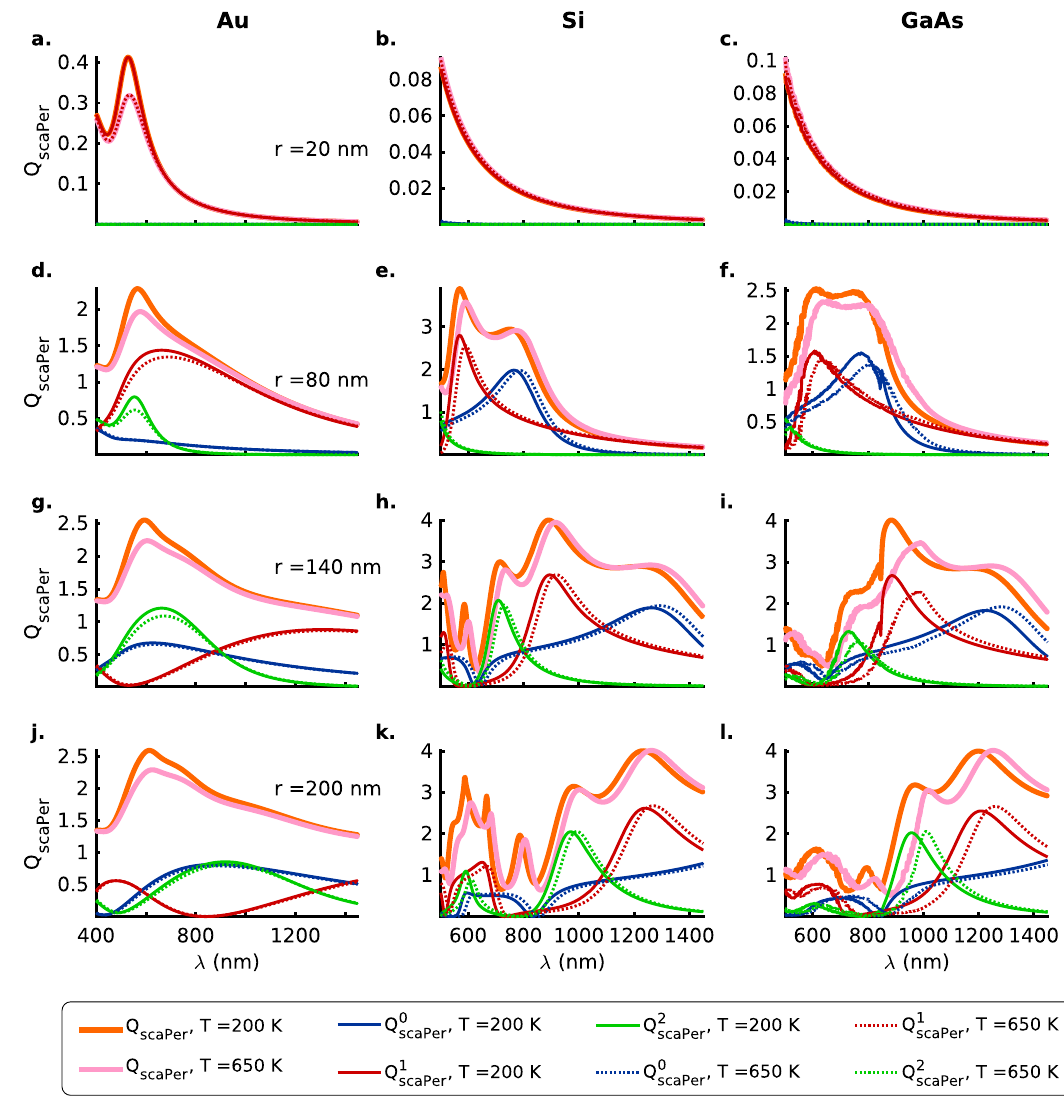
Figure 2. Mie scattering efficiency ( Q scaPer ) for the TE ( E ) polarization of the incident radiation with zeroth ⊥ (blue), first (red) and second (green) order contributions as a function of the wavelength, (cid:31) , for ( a , d , g , j ) Au 20, 80, 140 and 200 nm , respectively, at (DL model), ( b , e , h , k ) Si and ( c , f , i , l ) GaAs nanowires of radii r = 200 (solid lines) and 650 (dotted lines) K . The thick orange and pink solid lines represent the temperatures T = 200 and 650 K , respectively. Here, the Mie computations total scattering efficiencies, Q scaPer , at temperatures T = for the nanowires of different sizes take into account their thermal expansion, although the text labels indicate the values for nanowire radii at 200 K . Also see Tables S1–S3 b in the Supporting Information for a summary of the spectral positions of the resonances, the contributing orders to the scattering resonances and the numeric values of the scattering efficiencies for the TE ( E ) ⊥